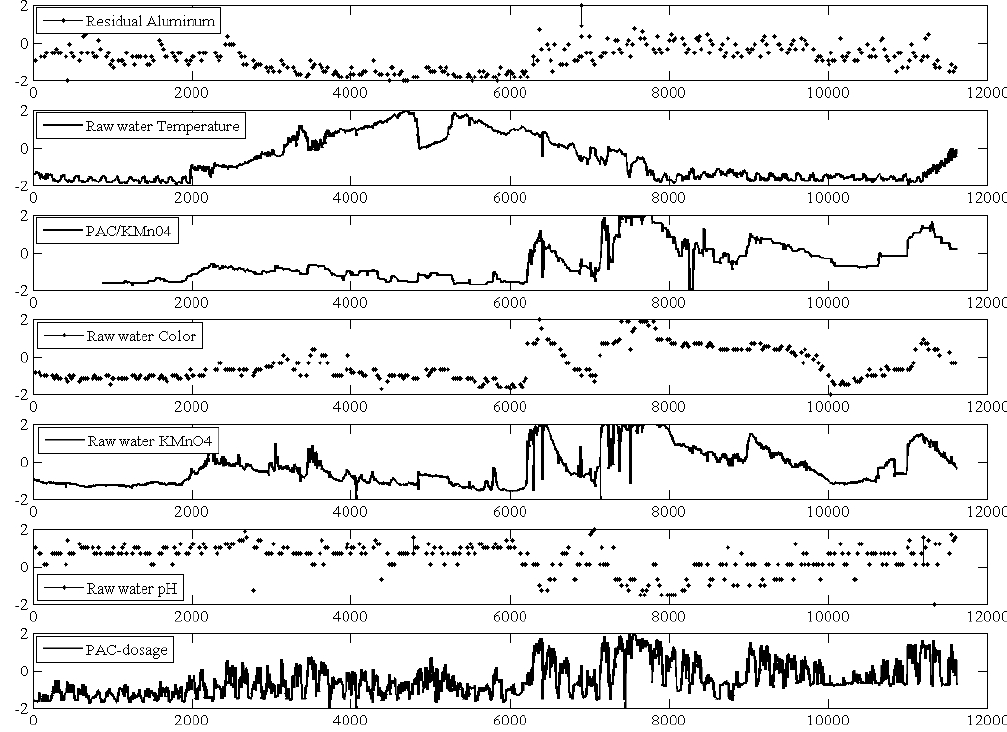
Figure 2. Trend lines of residual aluminum and important measurement variables. From top to down: residual aluminum, raw water temper- ature, PAC / KMnO 4 , raw water color, raw water KMnO 4 , raw water pH and